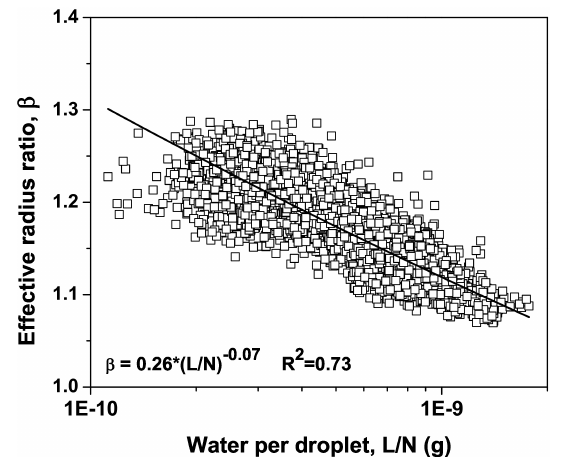
Figure 7. Scatter plot between water per droplet ( L/N ) and effec- tive radius ratio ( β) .